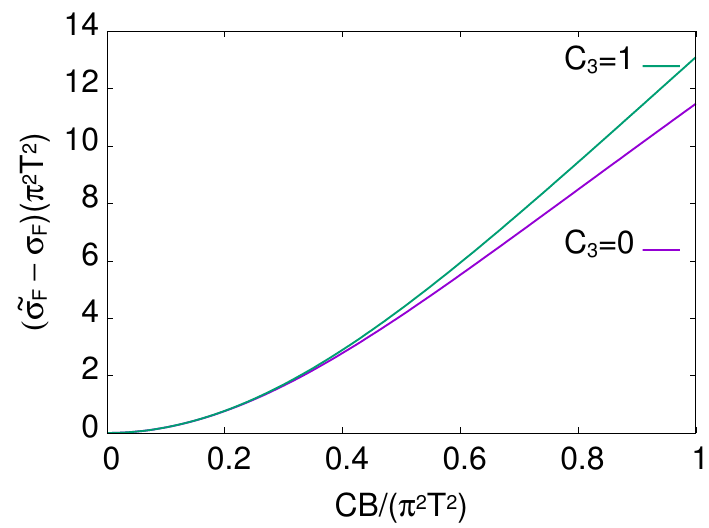
Figure 1 . The magnetic (cid:12)eld dependence of the real part of conductivity ~ (cid:27) F calculated from the equation (2.143) for a system described by (3.25). The upper curve is obtained for all C i 6 = 0, while the lower one for C 1 = C = 1 and C 3 = 0. The existence of Z 2 topological charge leads to narrowing of the magneto-conductivity. For actual calculations we have used T = 1, (cid:28) e = 0 : 1, ! =